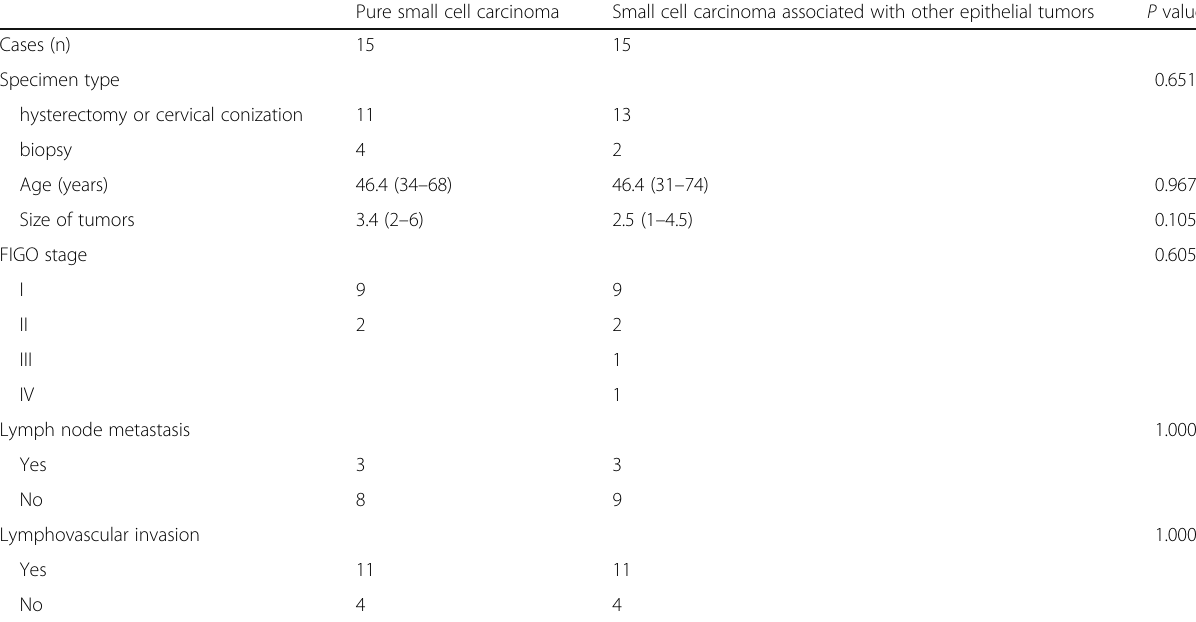
Table 1 Clinicopathological features of cervical small cell carcinoma with or without other types of epithelial tumors